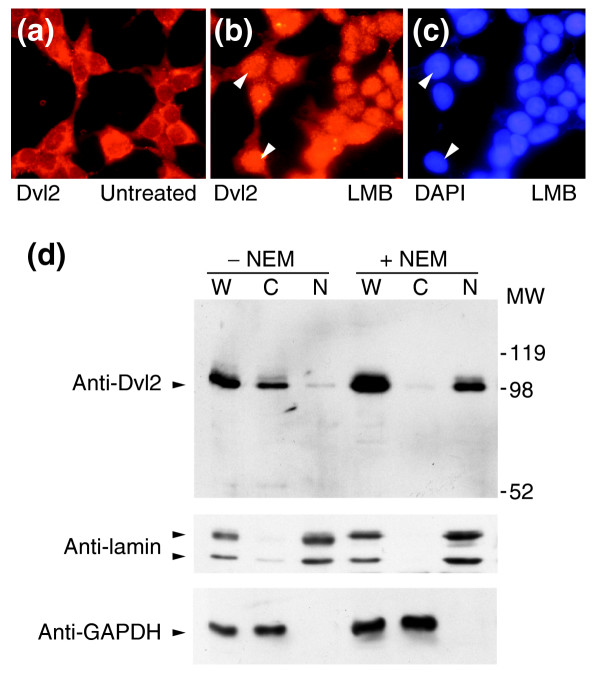
Endogenous Dsh shuttles between the cytoplasm and nucleus. Immunofluorescent staining of HEK293 cells with anti-Dvl2 antibodies reveals different subcellular localization of Dvl2 (a) without or (b) with LMB treatment. (c) DAPI staining shows the location of nuclei in the same field as (b); the arrowheads indicate corresponding nuclei in (b) and (c). (d) Distribution of endogenous Dvl2 recognized by anti-Dvl2 antibodies in the nuclear and the cytoplasmic fractions of Rat-1 fibroblasts. In the absence of NEM, Dvl2 is localized mainly in the cytoplasm (C), while after NEM treatment Dvl2 is exclusively localized in the nuclei (N). W, whole cell lysate. Antibodies to lamin and GAPDH show the separation of the nuclear and cytoplasmic fractions.